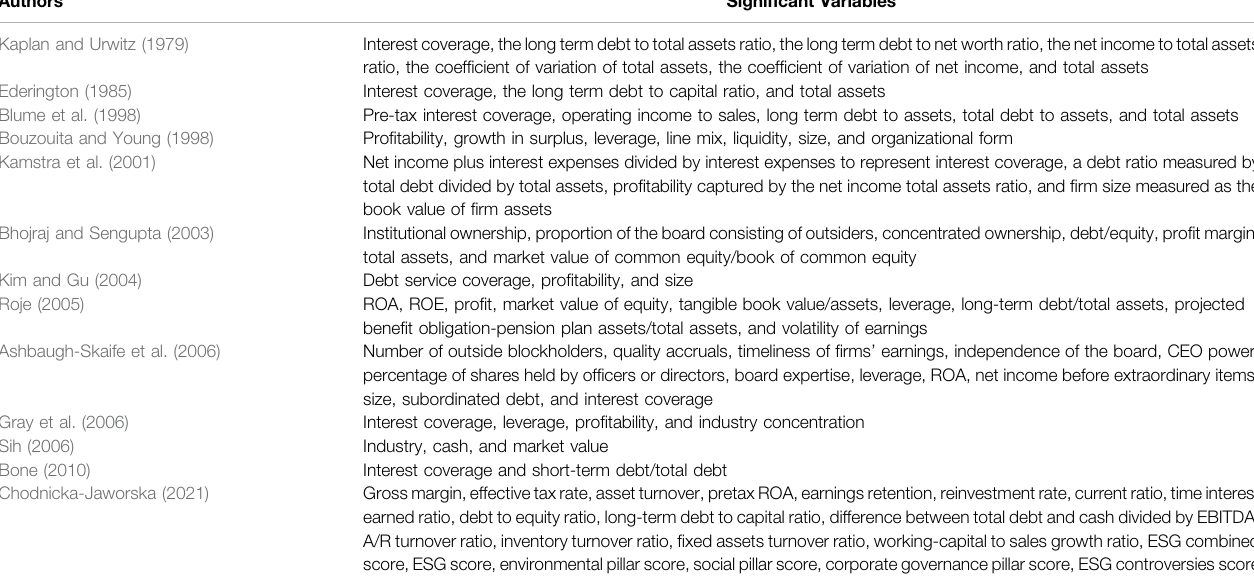
TABLE 1 | Studies about fi nancial factors in fl uencing corporate credit